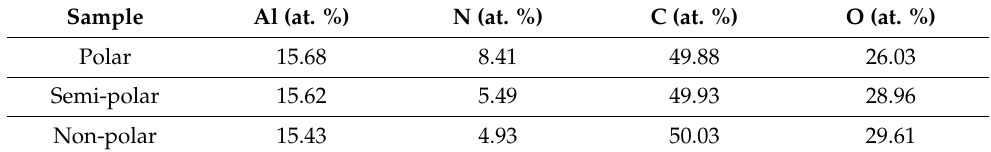
Table 2. The elemental concentrations of the unannealed polar, semi-polar and non-polar films.